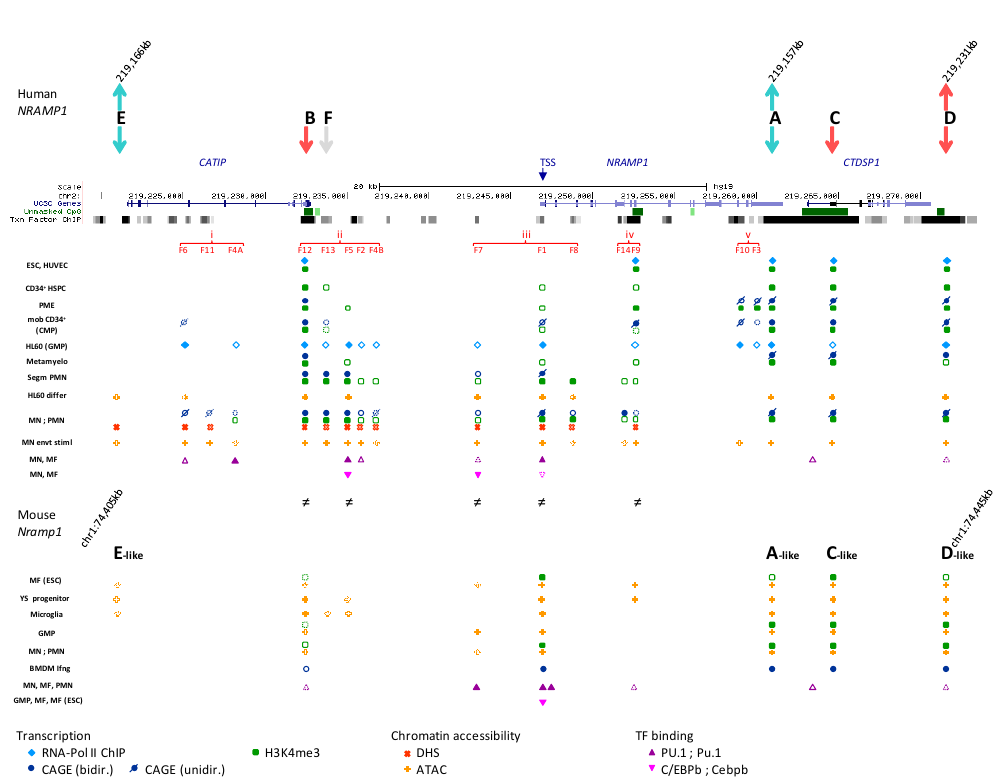
Figure 8. Recap of transcriptional activity, chromatin accessibility and TF binding at human and mouse Nramp1 loci compiled for selected cell types. Human locus, from top to bottom: CTCF sites (F orientation, red; R orientation, blue; undetermined orientation, grey); coordinates above sites E, A and D indicate potential interaction sites creating regulatory loops; chr2 scale; UCSC genes (names indicated above); CpG islands; ENCODE transcription factor ChIP-seq data. Position of regulatory regions i–v, including DHS F1-F14; cell types: non hematopoietic: ESC and HUVEC; hematopoietic: CD34 + HSPC, mature polymorphonuclear eosinophil (PME), successive stages of myelo-monocytic differentiation, including mobilized CD34 + progenitors (CMP proxy), acute myeloid leukemia HL60 (GMP proxy), neutrophilic metamyelocyte (metamyelo), segmented polymorphonuclear neutrophil (segm PMN), differentiated HL60 cells (PMN, MN, MF), mature MN and PMN, and mature MN stimulated with environmental stimuli (MN envt stiml). (cid:54) = symbols indicate that human and mouse regulatory elements are not functionally equivalent. Mouse locus, from top to bottom: Ctcf sites; hematopoietic cell types: in vitro ESC-derived MF; yolk sac (YS) MF progenitors; microglia; bone marrow GMP, MN and PMN; Ifn-gamma stimulated BMDM. Transcription related signals: CAGE tags, RNA Pol II, H3K4me3, PU.1 and C/EBPb ChIP-seq data and chromatin accessibility data: DNase